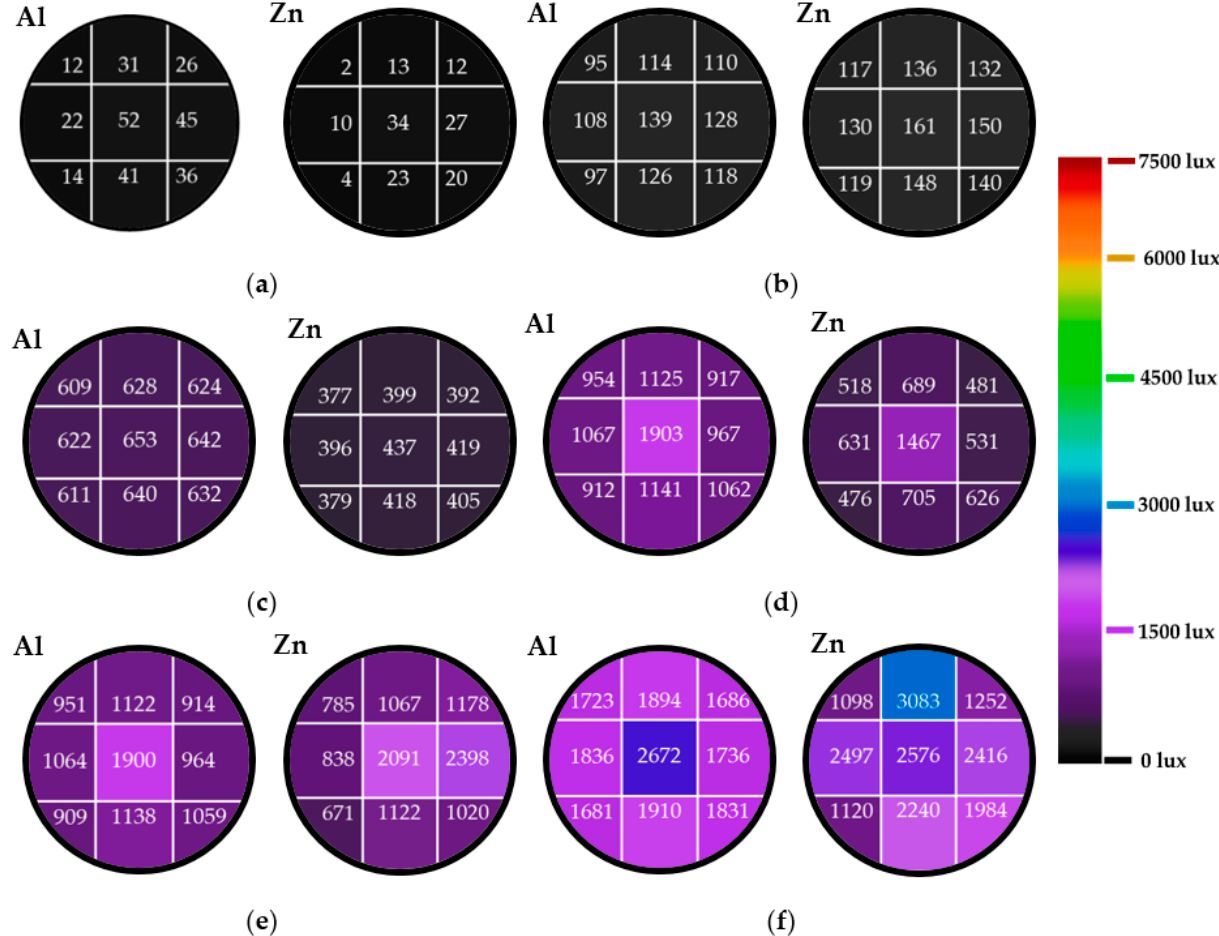
Figure 6. Illumination contours of aluminum alloy and zinc alloy hollow light pipe on the bottom end positions at the incident light angles of ( a ) 0°, ( b ) 15°, ( c ) 30°, ( d ) 45°, ( e ) 60°, and ( f ) 75°.